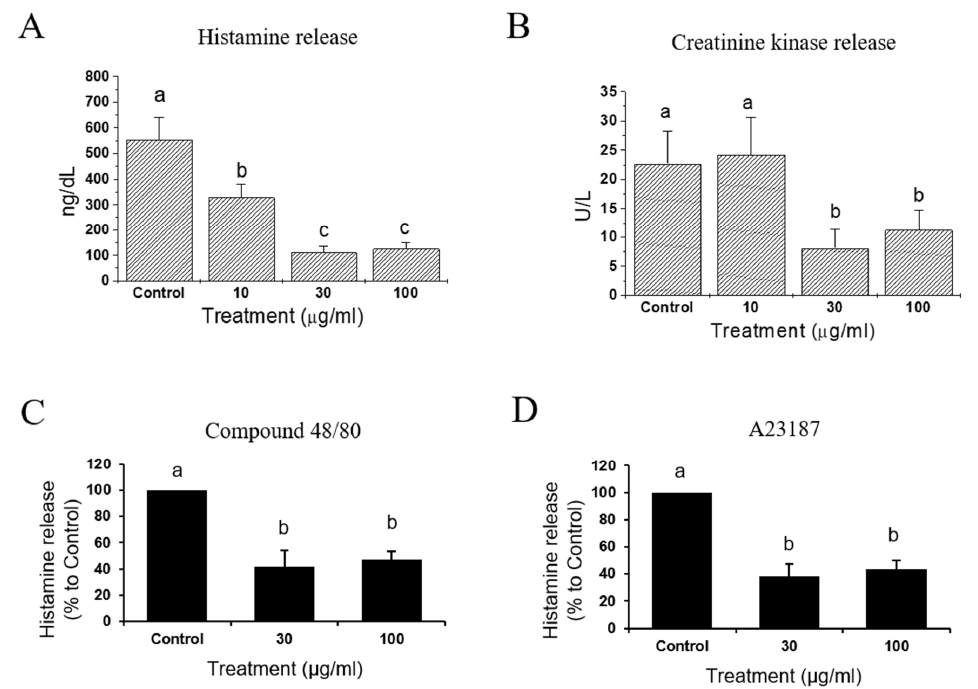
Figure 5. Effects of isoquercitrin (IQ) on histamine and creatinine kinase release. ( A ) Histamine and ( B ) creatinine kinase release were measured in OVA (1 mg)-treated isolated hearts from Hartley